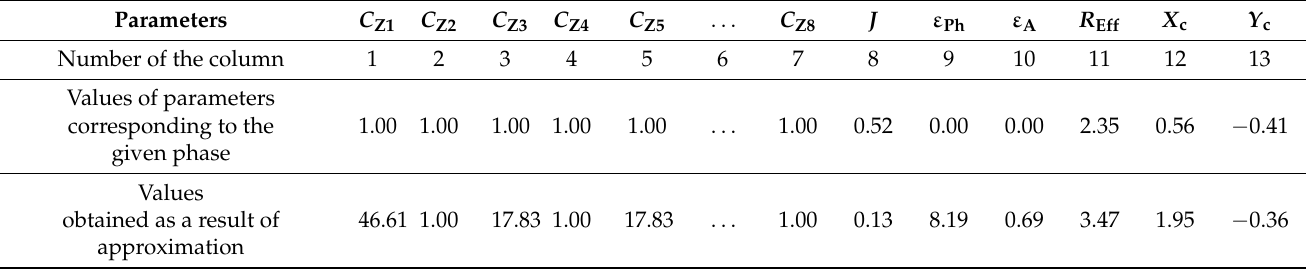
Table 5. The screen was set by 9 polynomials and approximated by 8 polynomials.